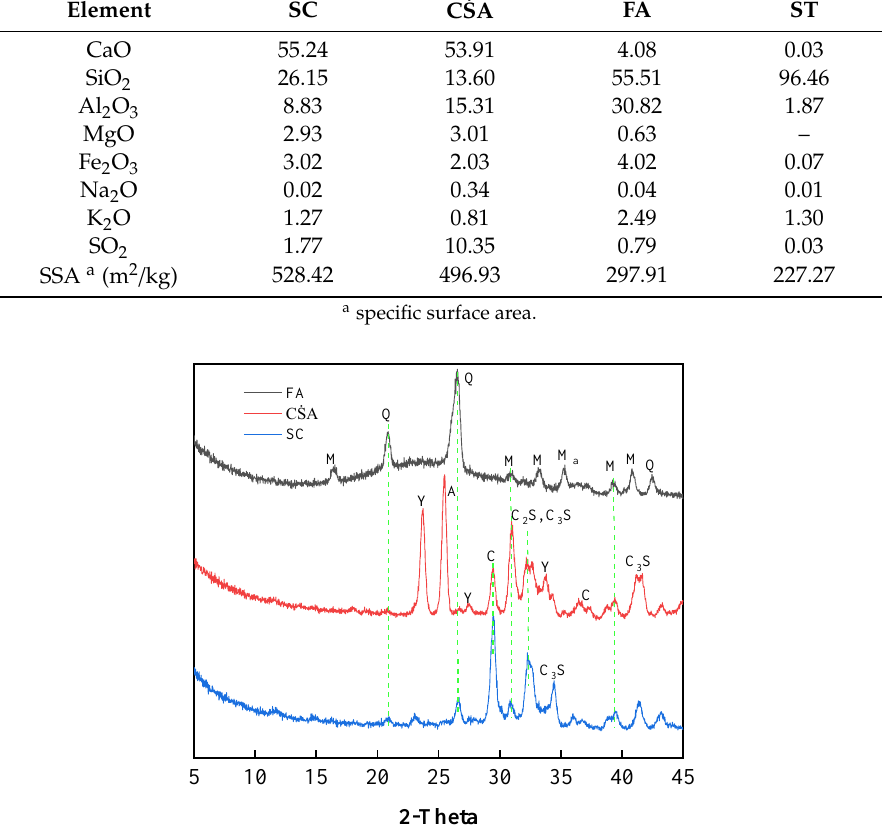
Figure 2. XRD patterns of FA, C˙SA, and SC (Q—quartz, A—Anhydrite, C—calcite, Y—ye’elimite, M—mullite, M a —magnetite).